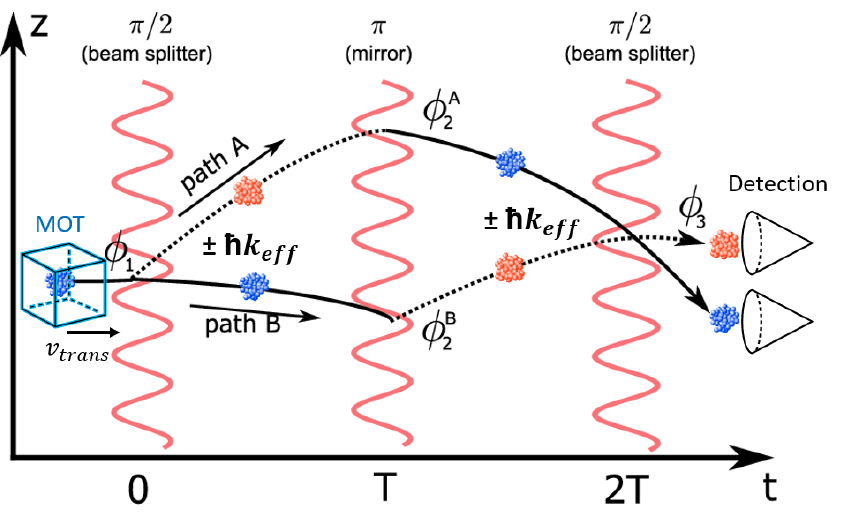
Figure 2. CAI measurement sequence adapted from [48]. The lines indicate the classical trajectories of the atoms under the influence of gravity, the colours represent two-level internal